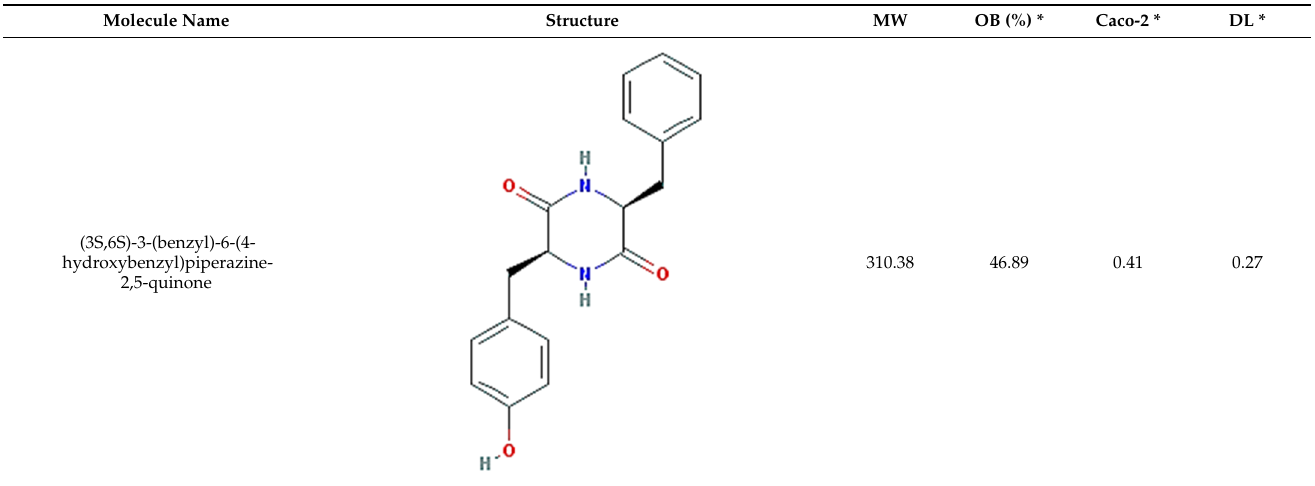
Table 1. Active compounds of Pinellia ternate Breitenbach.